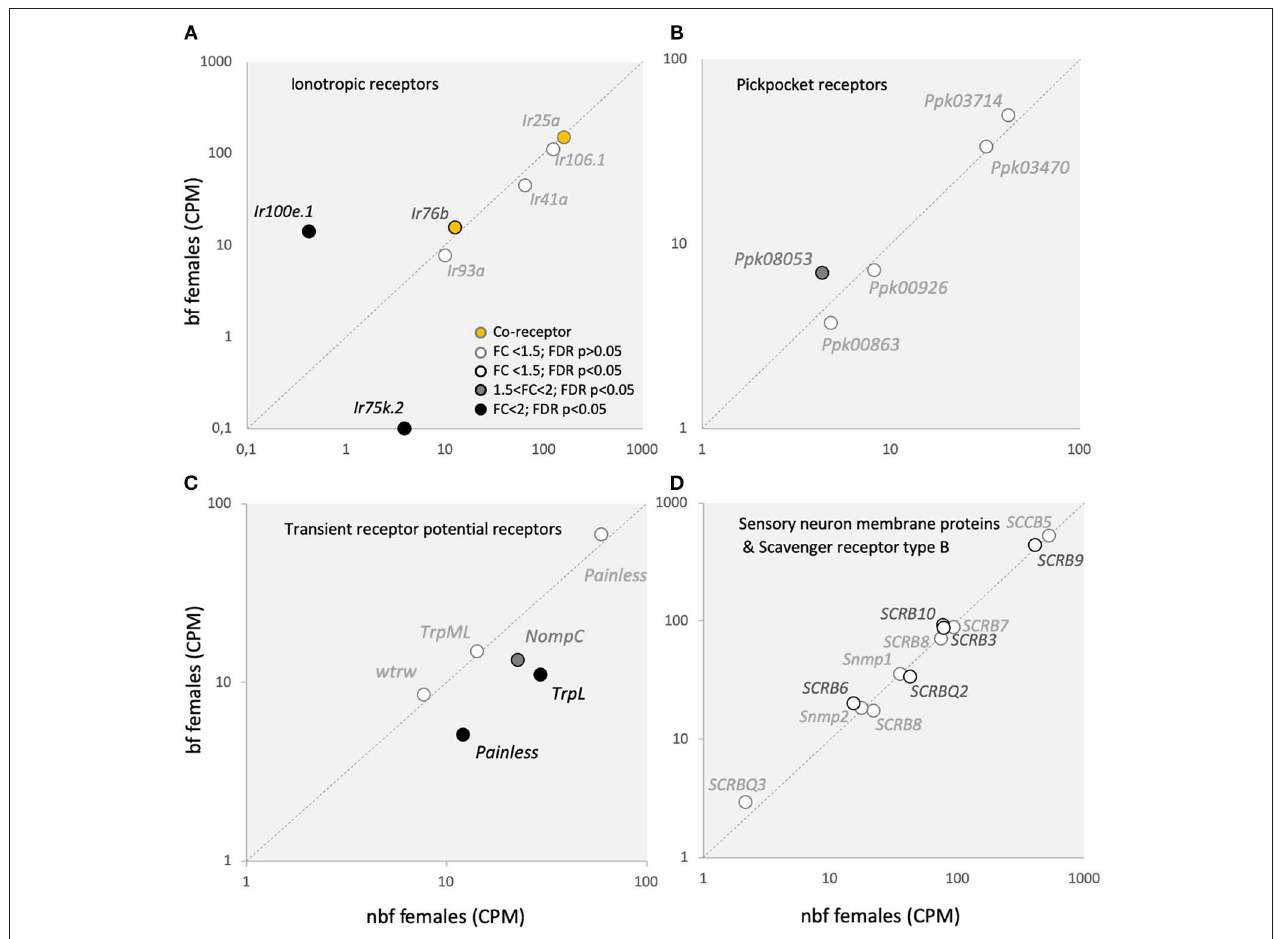
FIGURE 5 | Sensory receptor transcript abundance. Transcript regulation of (A) ionotropic receptor (Ir) co-receptors, Ir25a and Ir76b (orange-filled circles), as well as other Irs; (B) pickpocket receptors ( Ppks ); (C) transient receptor potential receptors ( Trps ); and (D) sensory neuron membrane proteins ( Snmps ) and scavenger receptors type B ( SCRBs ) is presented as the normalized number of reads in the maxillary palps of blood fed (bf) and non-blood fed (nbf) Aedes aegypti females. Transcripts that exhibit significant differences in abundance (Kal’s test; FDR P < 0.05) are denoted according to their fold change (FC); FC > 2 in black-filled circles; 1.5 < FC < 2 in gray-filled circles; and FC < 1.5 in unfilled circles. The gray dotted line indicates a hypothetical equal transcript abundance between the